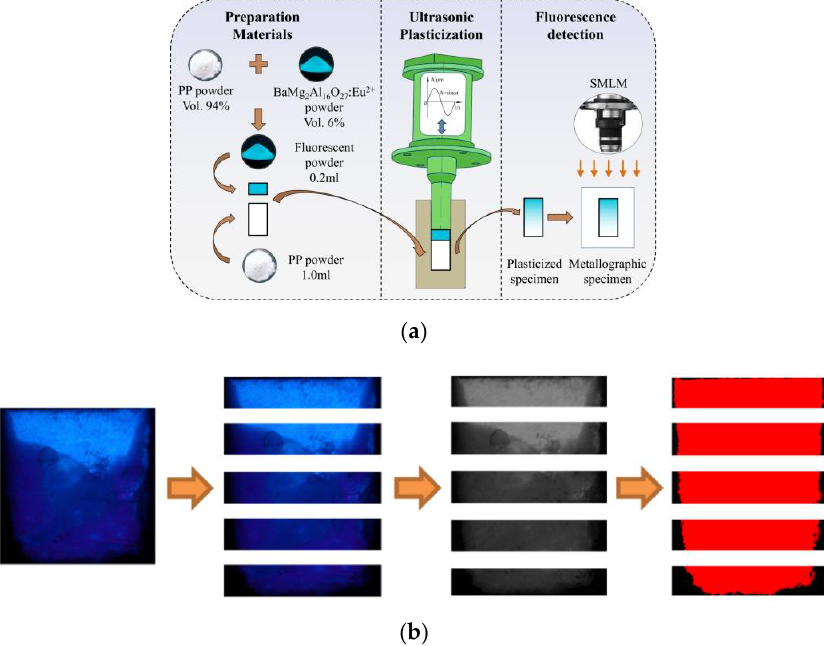
Figure 2. Specimen preparation and characterization. ( a ) Experimental procedures. ( b ) Segmentation and characterization of the fluorescence